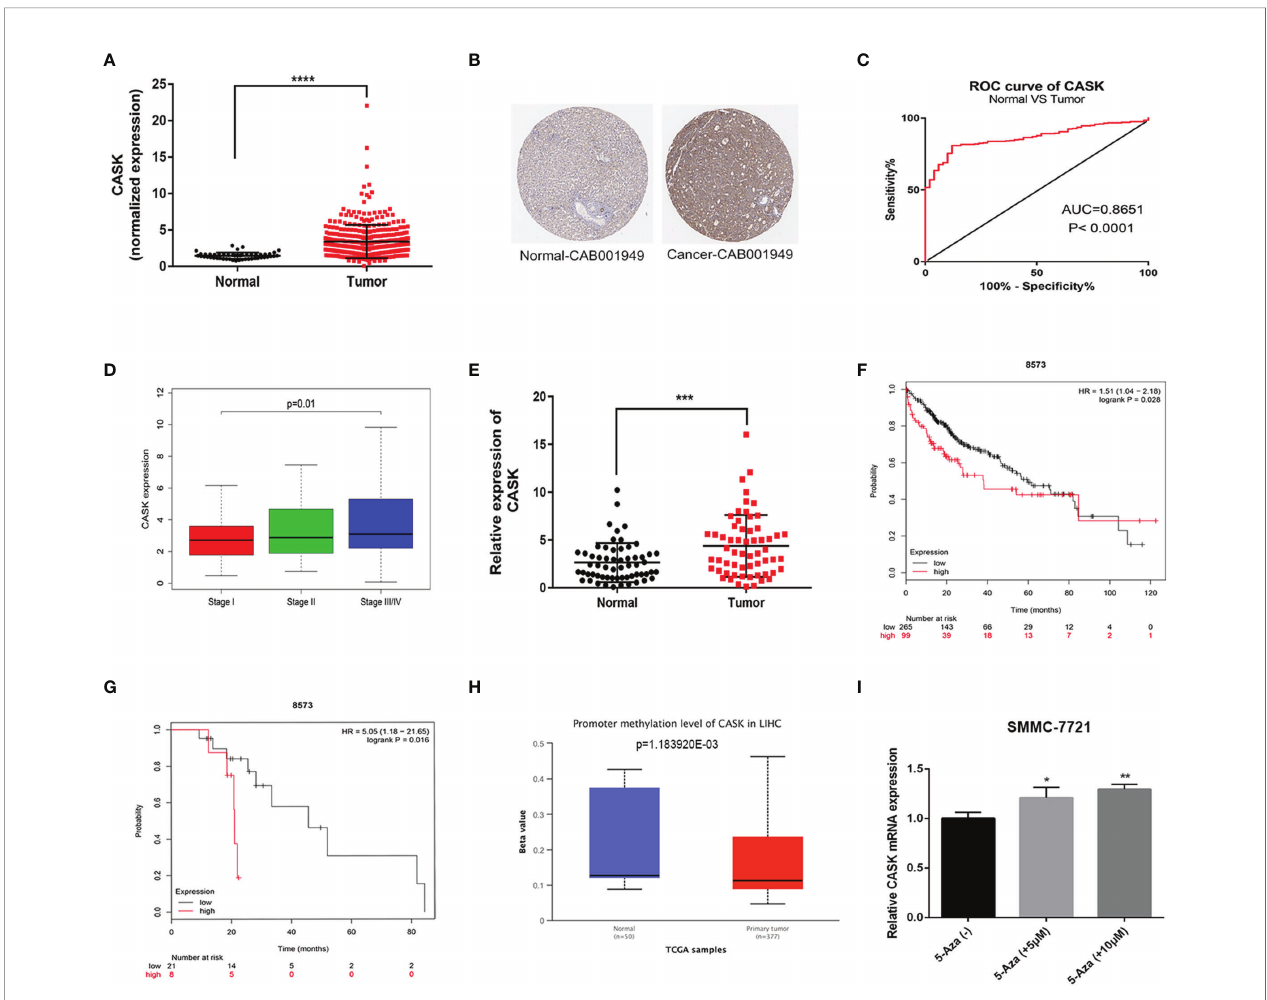
FIGURE 1 | CASK expression was elevated in HCC, and correlated with sorafenib resistance and poor prognosis. (A) Expression of CASK in HCC tissues were compared with normal tissues from TCGA database. (B) IHC of CASK expression in HCC tissue and normal tissue through using HPA database. (C) ROC curve analysis of CASK in HCC. (D) The correlation analysis between CASK levels and the stage in HCC cancer patients. (E) qRT-PCR analysis of CASK mRNA expression levels in 60 paired HCC tissues and corresponding normal tissues. (F) The Kaplan – Meier survival analysis of overall survival for HCC patients. (G) The Kaplan – Meier survival analysis of overall survival for HCC patients with sorafenib treated. (H) The promoter region methylation levels of CASK in HCC and normal tissues from UALCAN database (http://ualcan.path.uab.edu/). (I) qRT-PCR analysis detecting the CASK levels in SMMC-7721 cells after treatment with 5 m